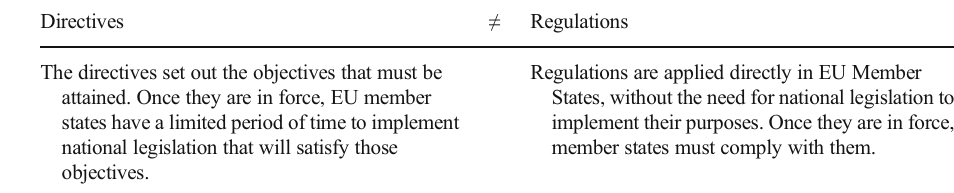
Table 2 Main differences between Directives and Regulations